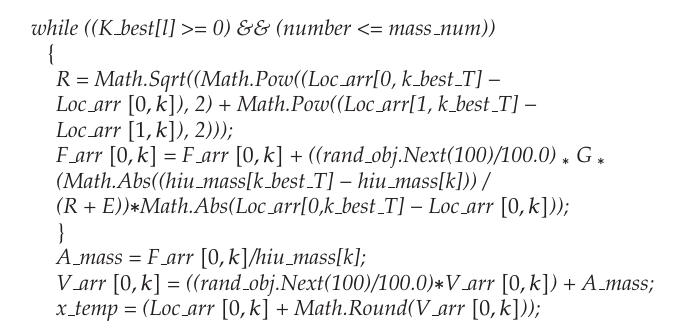
Algorithm 2: Calculating for each mass.